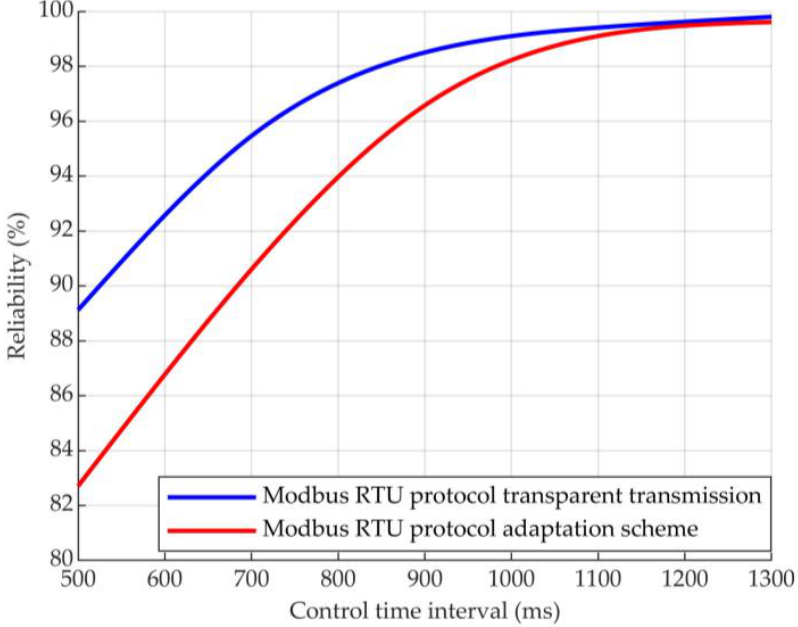
Figure 19. The reliability comparison between protocol adaptation and prototype transparent trans- mission for Modbus RTU.